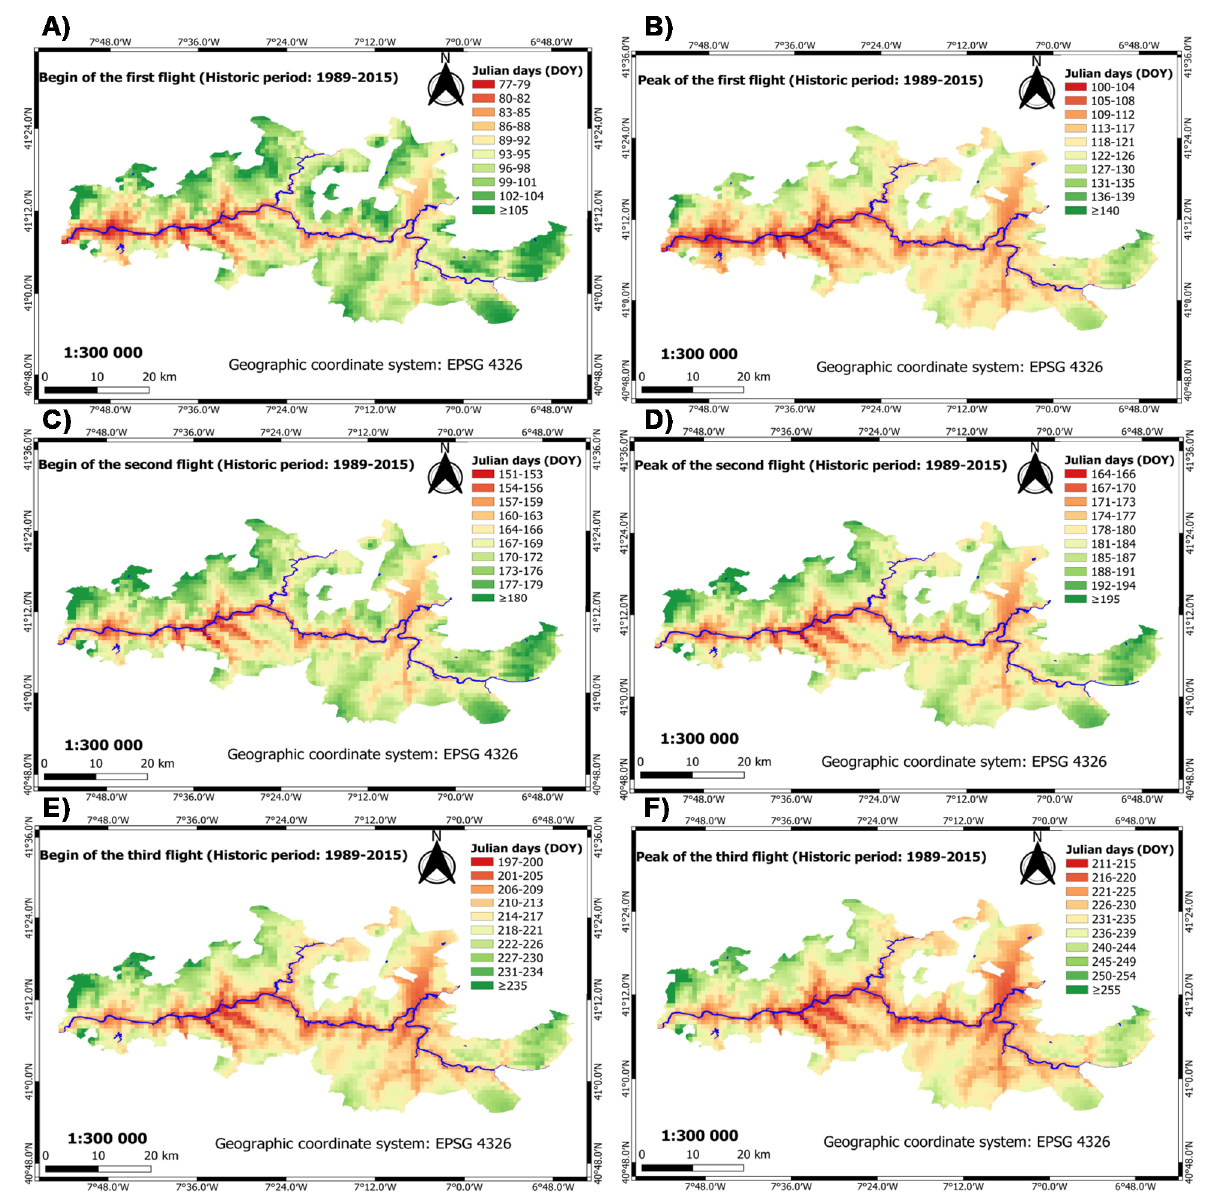
Figure 4. Phenology maps for the historic period (1989–2015) covering the entire Douro Demarcated Region. The color scale represents the Julian days (DOY) obtained by the phenology models for each beginning (left) and peak (right) of the flight, namely the first ( A , B ), second ( C , D ) and third ( E , F ). In addition, the Douro river and main tributaries are also outlined (thick blue line).